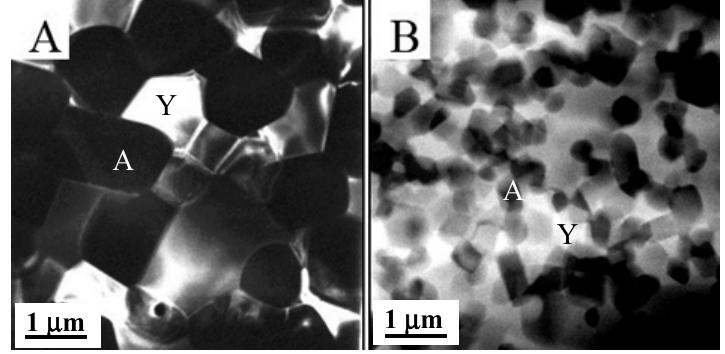
Figure 5. Transmission Electron Microscopy (TEM) images of AY materials. ( a ) Un-milled powder, sintered ad 1600 °C/3 h; ( b ) Milled powder sintered at 1420 °C/3 h. Characters A and Y refer to α -Al 2 O 3 (black grains) and YAG (white grains),